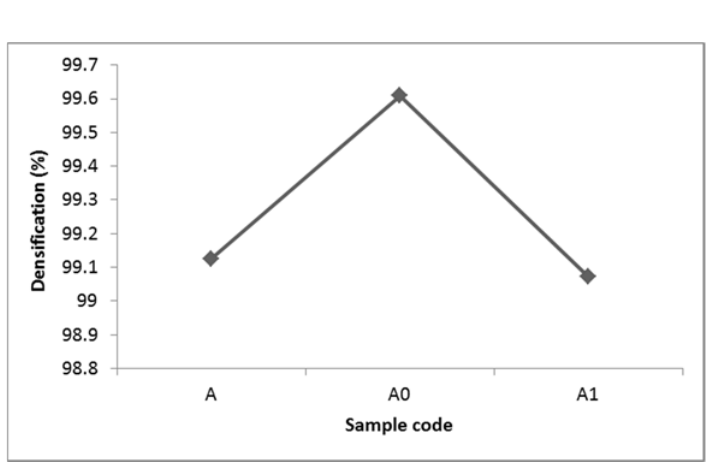
Figure 5. Densification results of synthesized Ti-Al-xNb.